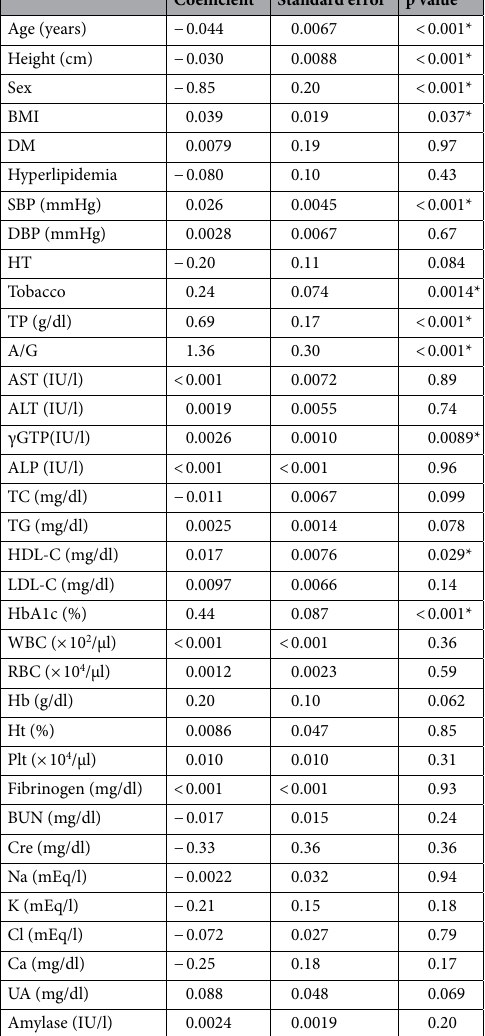
Table 4. Result of MLM obtained with the training dataset. *Represents the p value < 0.05. MLM multivariate linear regression, IOP intraocular pressure, BMI body mass index, BP blood pressure, BNP brain natriuretic peptide, TP total protein, A/G albumin/globulin, AST aspartate aminotransferase, ALT alanine aminotransferase, γGTP guanosine triphosphate, ALP alkaline phosphatase, HDL-C high-density lipoprotein cholesterol, LDL-C low-density lipoprotein cholesterol, HBA1c glycosylated hemoglobin A1c, WBC white blood cell, RBC red blood cell, BUN blood urea nitrogen, Na sodium, k potassium, Cl chlorine, Ca